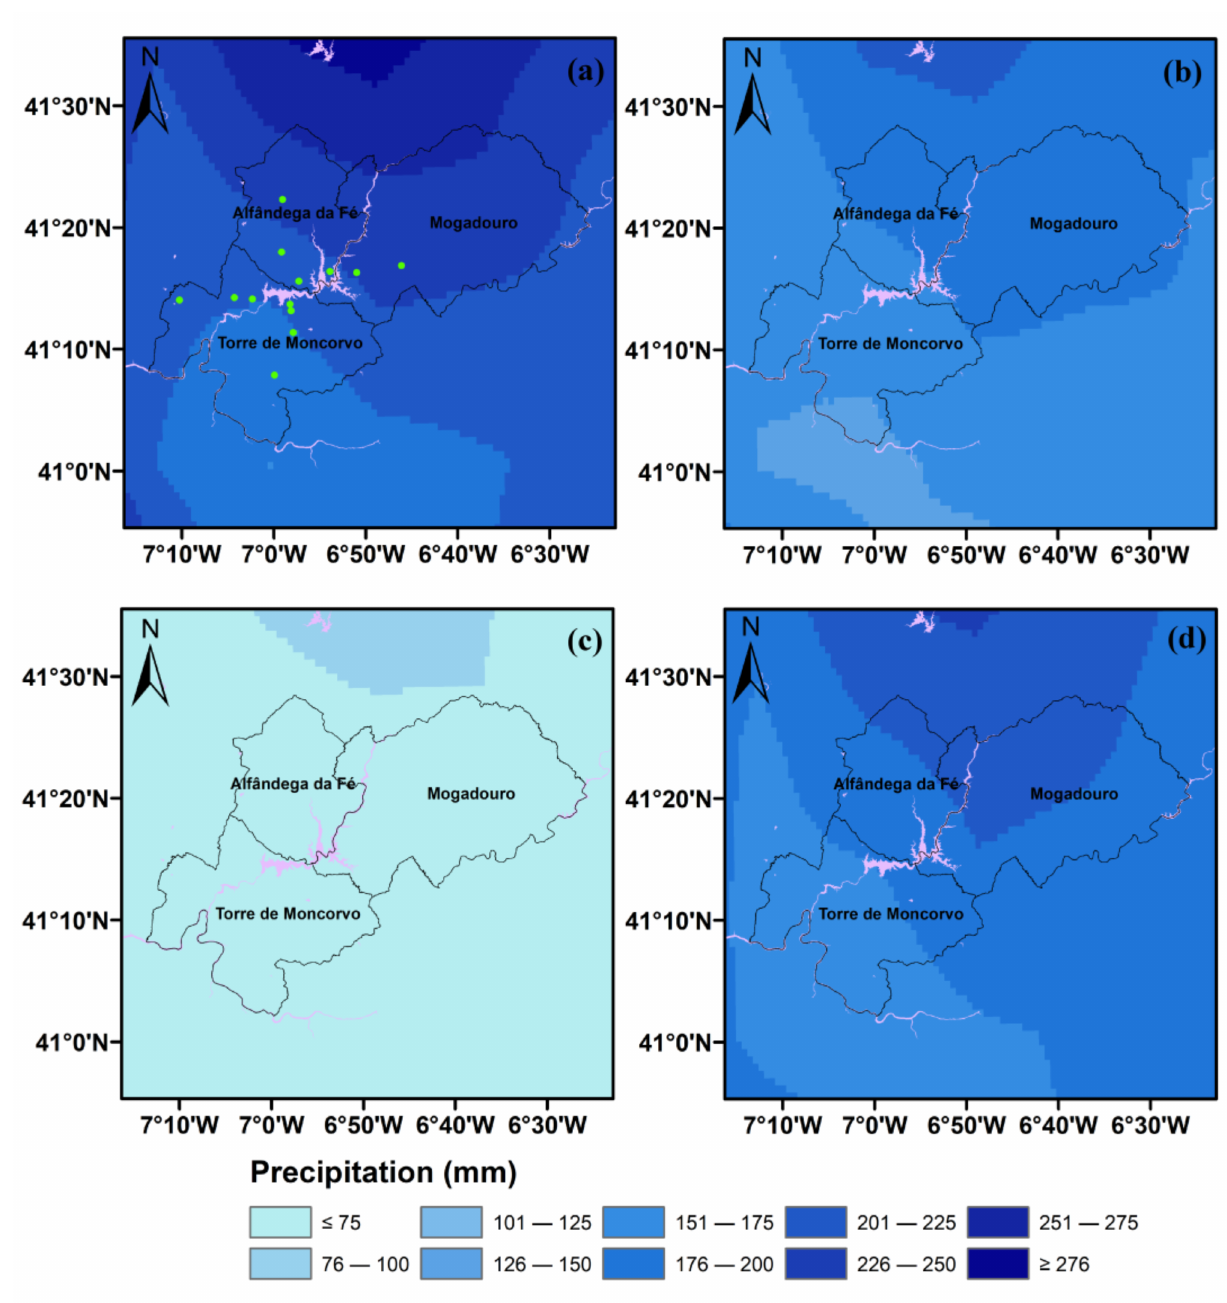
Figure 3. Spatial distribution of total precipitation in the target region of the Baixo Sabor Hydroelectric Plant (BSHP) for the period 2011–2020: ( a ) winter; ( b ) spring; ( c ) summer; and ( d )